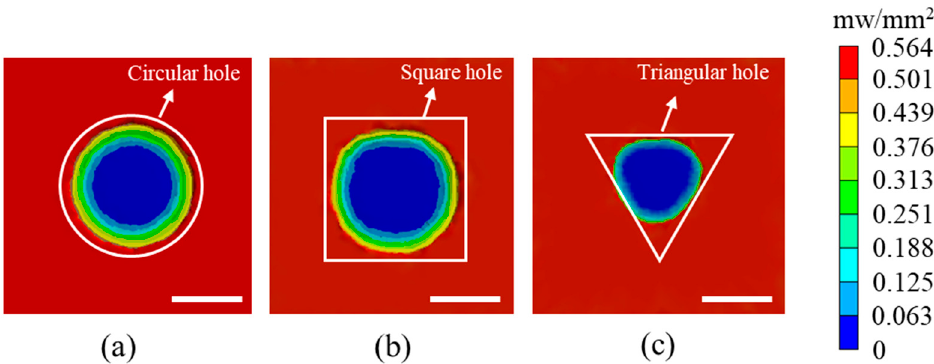
Figure 4. The simulation results for the power intensity distribution. ( a ) The projection pattern for the circular hole with a diameter of 100 µm, ( b ) the pattern for the square hole with a length of 100 µm and ( c ) the pattern for the regular triangle hole with a length of 100 µm. Scale bar: 50 µm.